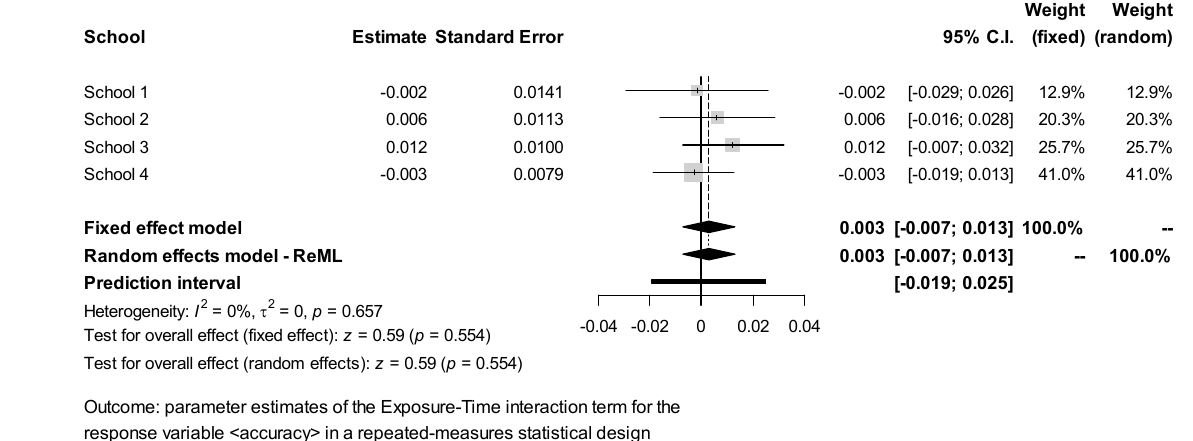
Figure 3. Meta ‐ analysis for test response accuracy.